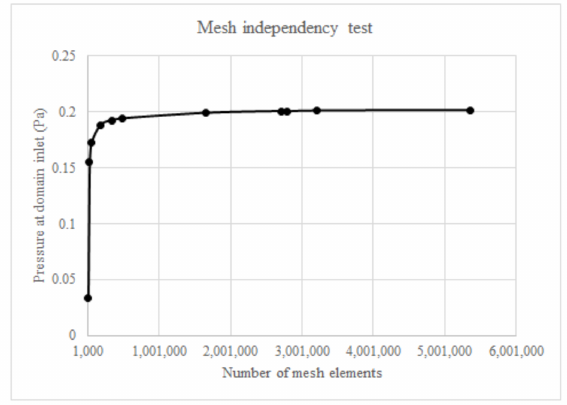
Figure 3. Mesh independency